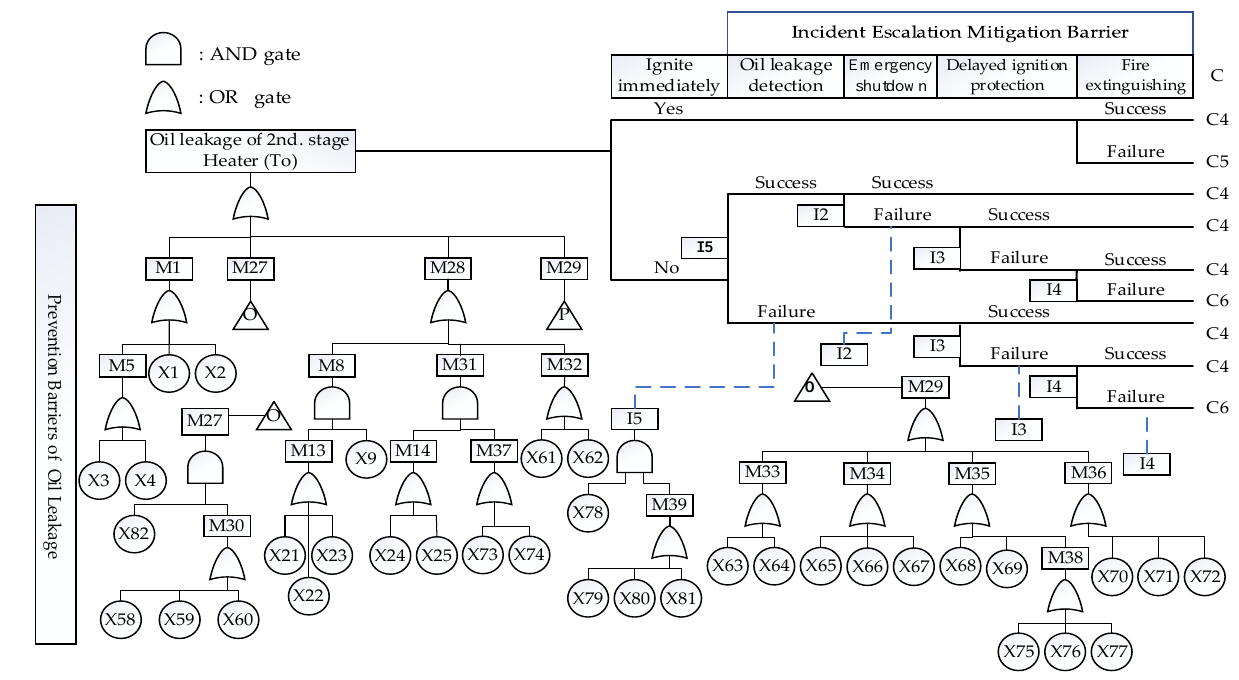
Figure 6. The BT model of gas leakage.